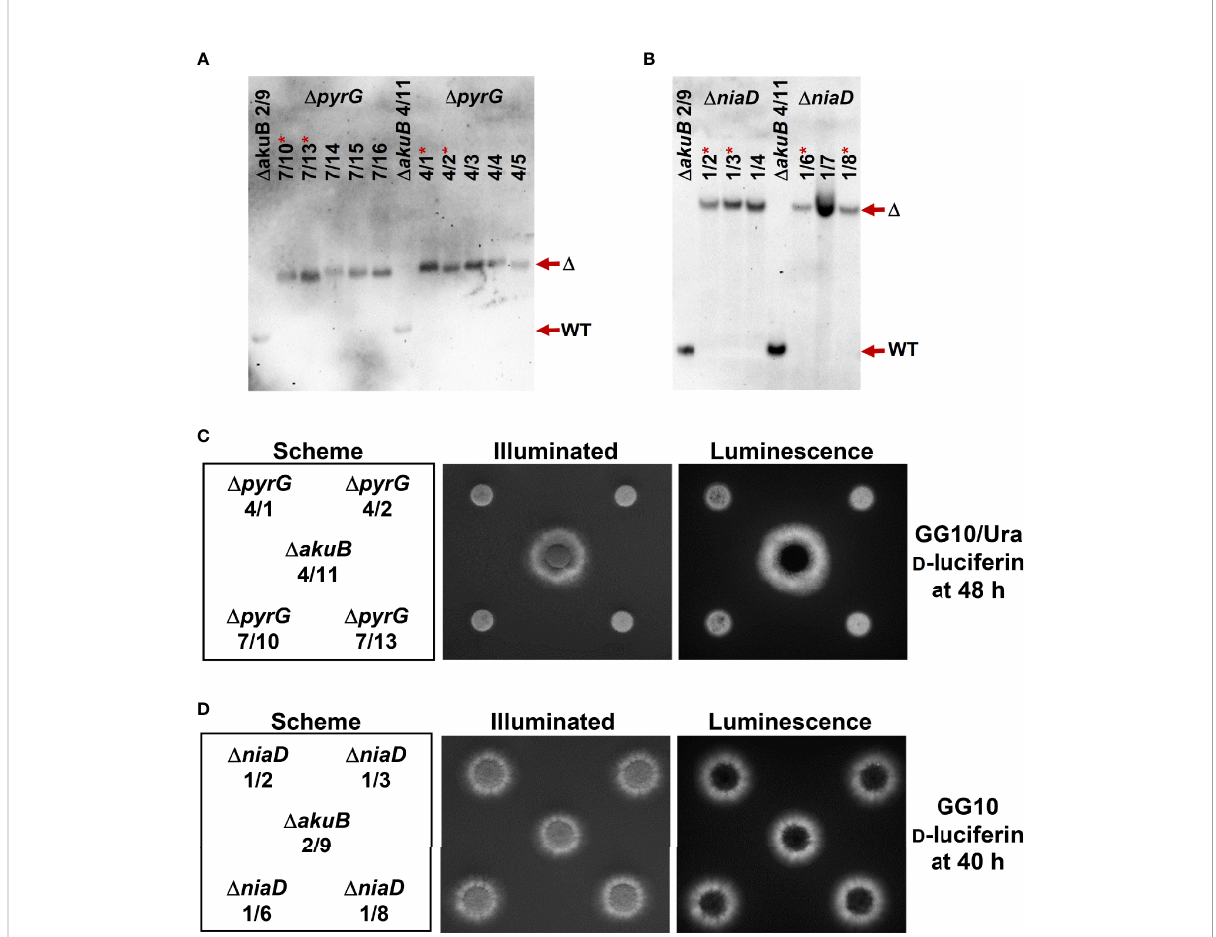
FIGURE 5 Southern blot and bioluminescence analysis of D pyrG and D niaD mutants generated from bioluminescent D akuB strains. (A, B) Southern blot analyses of randomly selected transformants obtained from the parental D akuB strains 2/9 and 4/11. The parental strains provide show the regions of the respective wild-type signals (WT) of pyrG and niaD . (A) D pyrG detection with a digoxygenin-labelled probe against the upstream region of the pyrG gene. Genomic DNA was restricted with Hind III resulting in expected signals of 2239 bp for the wild-type (WT) and 4056 bp for deletion mutants ( D ). (B) D niaD detection with a digoxygenin-labelled probe against the upstream region of the niaD gene. Genomic DNA was restricted with Xho I resulting in signals expected at 1635 bp for the wild-type (WT) and 6258 bp for deletion mutants ( D ). Strains in (A) and (B) denoted by a * were analysed in subsequent experiments. (C) Growth of the selected D pyrG strains on minimal medium containing 50 mM glucose as carbon and 10 mM glutamine as nitrogen source (GG10) and supplemented with 10 mM uracil and 0.3 mM D -luciferin. 10 4 conidia were spotted and plates were incubated for 48 h at 37°C before luminescence was detected. All D pyrG strains show reduced growth rates, but are positive for bioluminescence. (D) Bioluminescence analysis of D niaD strains. Plates were the same as in (C) , but without uracil supplementation. On this medium, no growth defect of D niaD is detected and all strains are positive for bioluminescence. In (C, D) a spotting scheme is shown on the left side with one parental D akuB strain in the centre. The picture in the middle shows an acquisition under illumination and the right side a luminescence acquisition in the